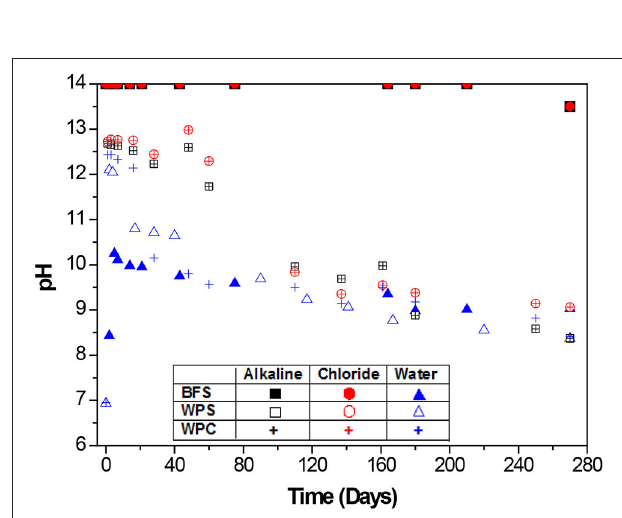
FIGURE 4 | Photographs and in situ Raman spectra of the steel rebars extracted from BFS, WPS, and WPC mortars that had been immersed in the alkaline chloride-rich solutions for 270 days.